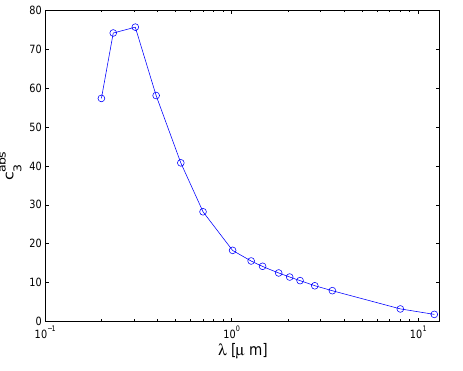
Fig. 5. Spectral dependency of the cubic fitting coefficient of C abs .